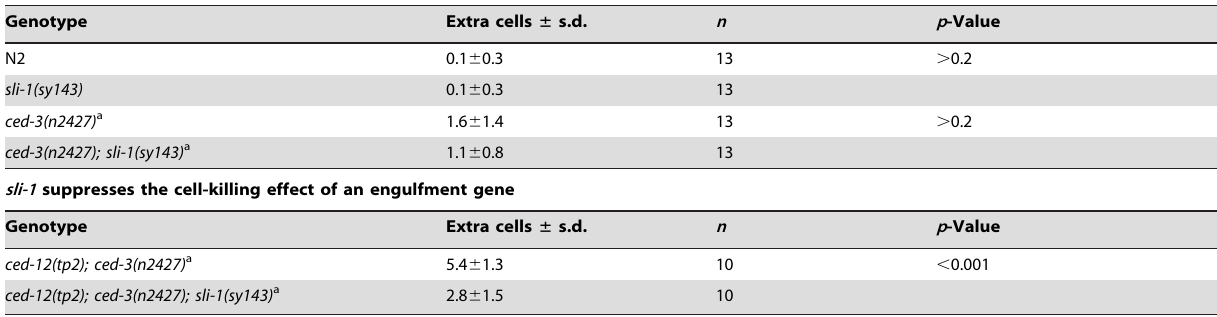
sli-1 mutation does not block cell death in the pharynx